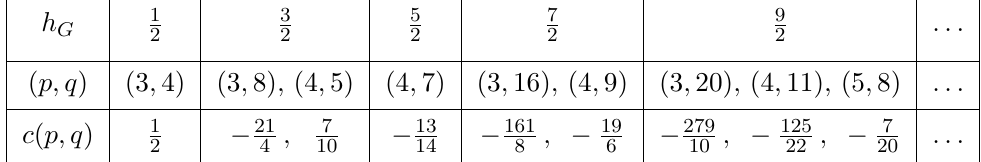
Table 1 . Virasoro minimal models admitting a fermionic generator G listed by increasing h G